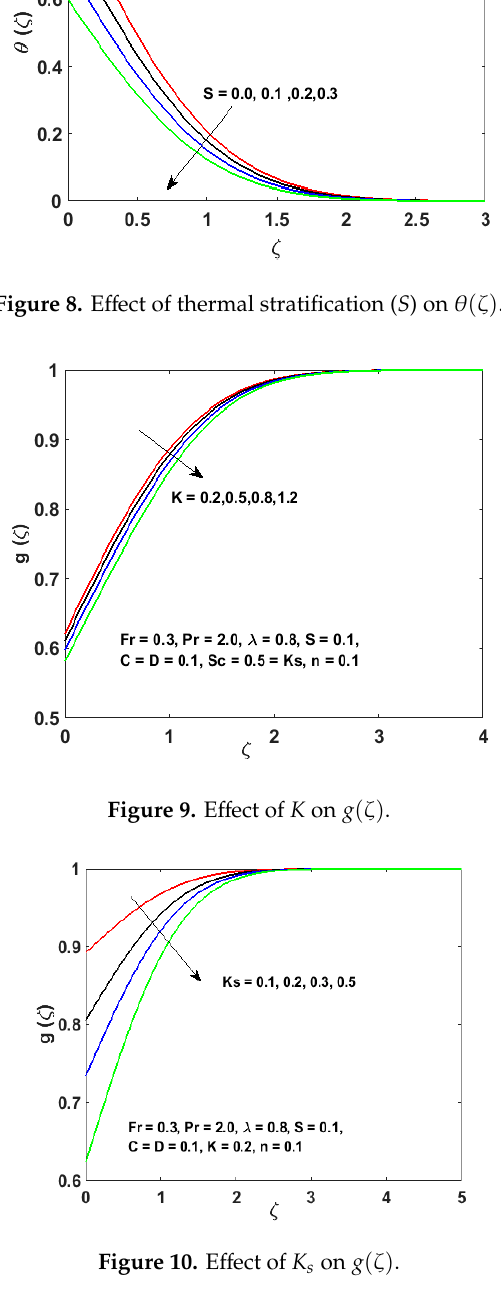
Figure 10. E ff ect of K s on g ( ζ ) Figure 10. Effect of Figure 10. Effect of